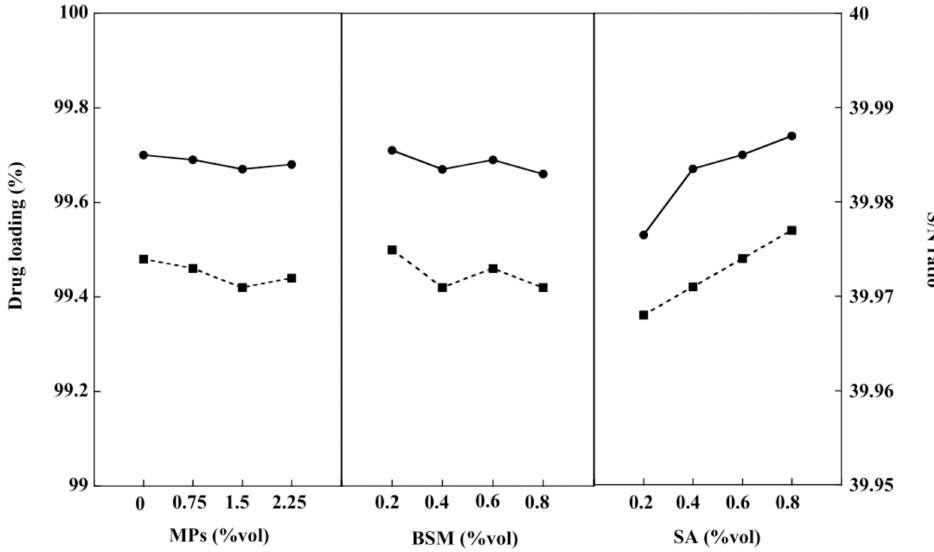
Figure 5. Drug loading (– • –) and S/N ratio (– (cid:4) –) of the BSM/SA/MPs hydrogel beads.